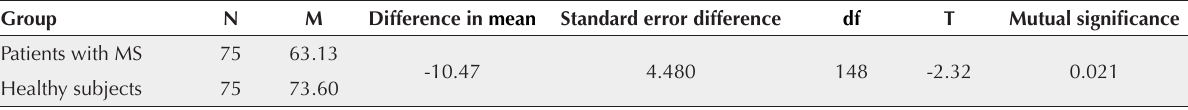
Table 4. Results from independent t test for resiliency variable Group N M Difference in mean Standard error difference df T Mutual significance Patients with